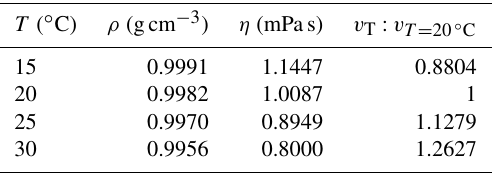
Table 1. The influence of temperature on sinking velocity. Density data are from Kell (1975), and viscosity data are from Kestin et al. (1978).